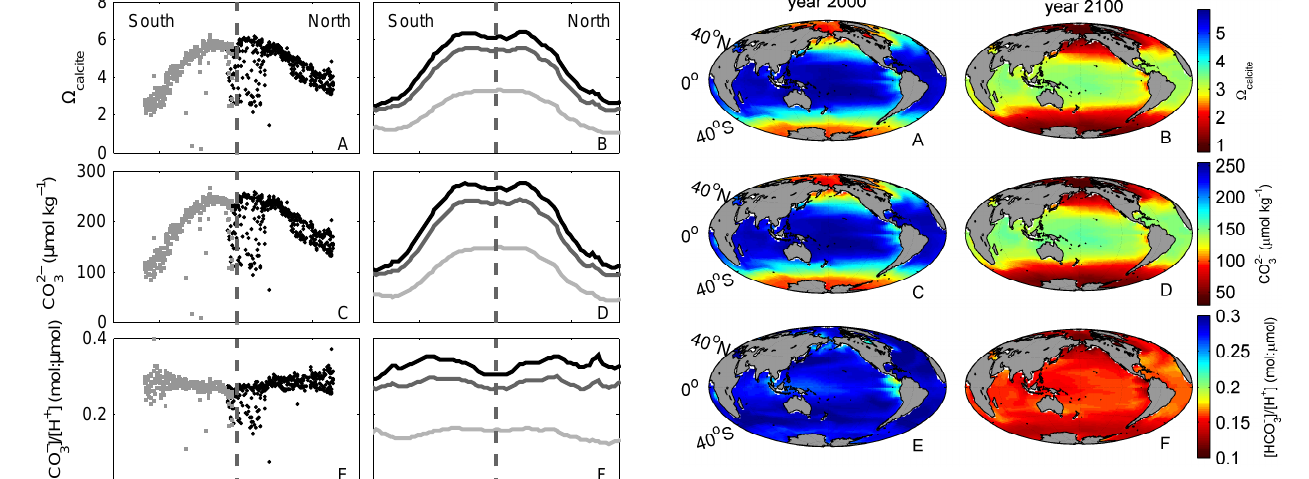
Figure 6. Surface ocean (0–50m) (cid:127) CaCO (a, b) , [CO 2 − ] (c, d) , 3 3 and [HCO − ] / [H + ] (e, f) in the year 2000 (left panel) compared 3 to 2100 (right panel) calculated with the UVic model. The pro- Figure 5. Change in (cid:127) CaCO , [CO 2 − ], and [HCO − ] / [H + ] in the 3 3 3 nounced latitudinal gradient of (cid:127) CaCO and [CO 2 − ] is absent in surface ocean along a meridional gradient. The left panels ( a , c , 3 3 [HCO − ] / [H + ] (see also Fig. 5). [HCO − ] / [H + ] is quite homoge- and e ) show compiled surface ocean (0–100m) data from two north 3 3 neous in 2000 and 2100 in all major ocean basins, with only some to south transects in the Atlantic, measured during CLIVAR CO 2 regional anomalies. These are found in some coastal areas (e.g., in cruises in 2003 (black dots) and 2005 (grey squares). The right pan- the Bering Sea) and in eastern boundary upwelling systems, most els ( b , d , and f ) show the latitudinal surface ocean (0–50m) aver- noticeably off the west coast of South and Central age calculated with the UVic model for the years 1770 (black line), 2000 (grey line), and 2100 (light grey line). The dashed vertical line illustrates the equator.